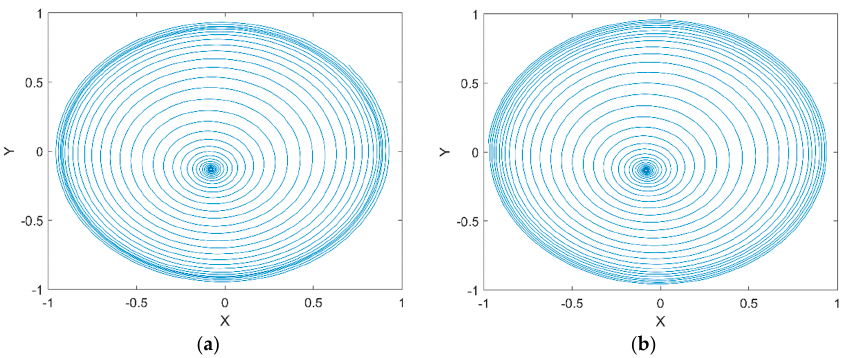
Rotor eccentricity variation with and without considering the UMF. Micromachines 2020 , 11 , x